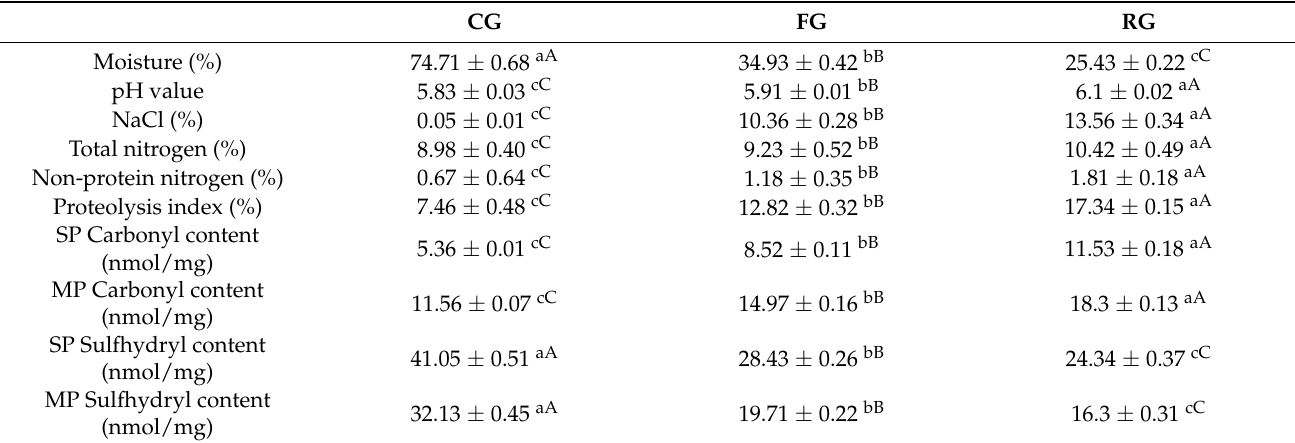
Table 1. Analysis of physicochemical characteristics of dry-cured beef during